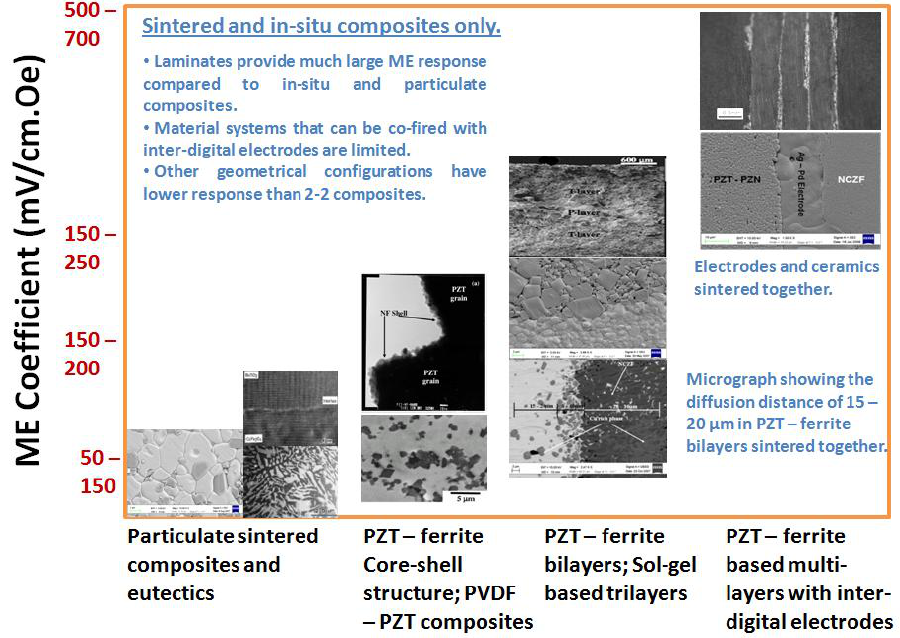
Figure 13. Magnetoelectric coefficient for various bulk sintered